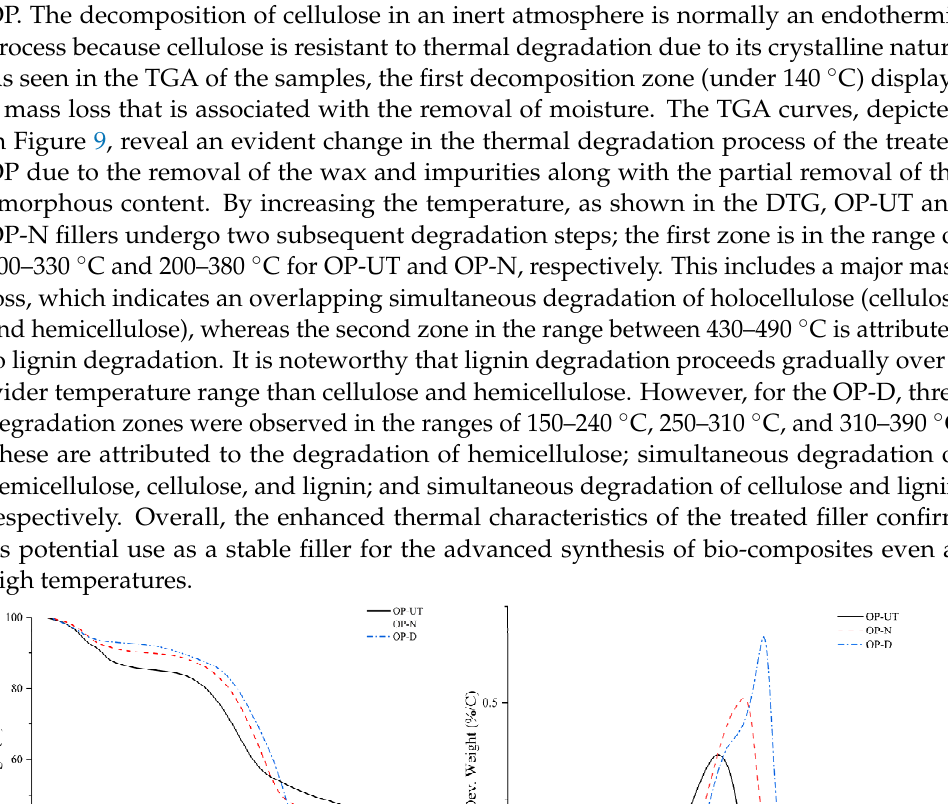
Figure 7. XRD patterns of the developed biocomposites in comparison to neat rLDPE.